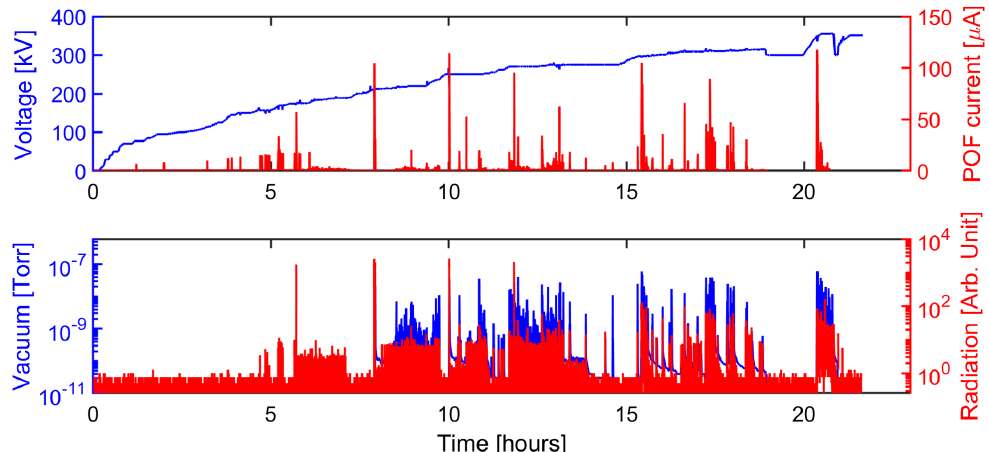
FIG. 5. HVPS conditioning process to reach 350